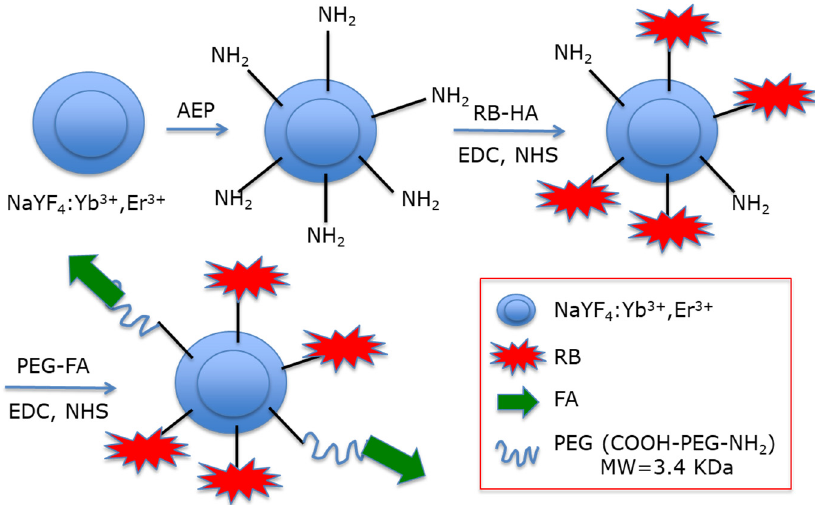
Figure 1. Covalent coupling of NaYF 4 :Yb 3+ and Er 3+ UCNPs with RB and FA. Adapted from Liu et al. [20].